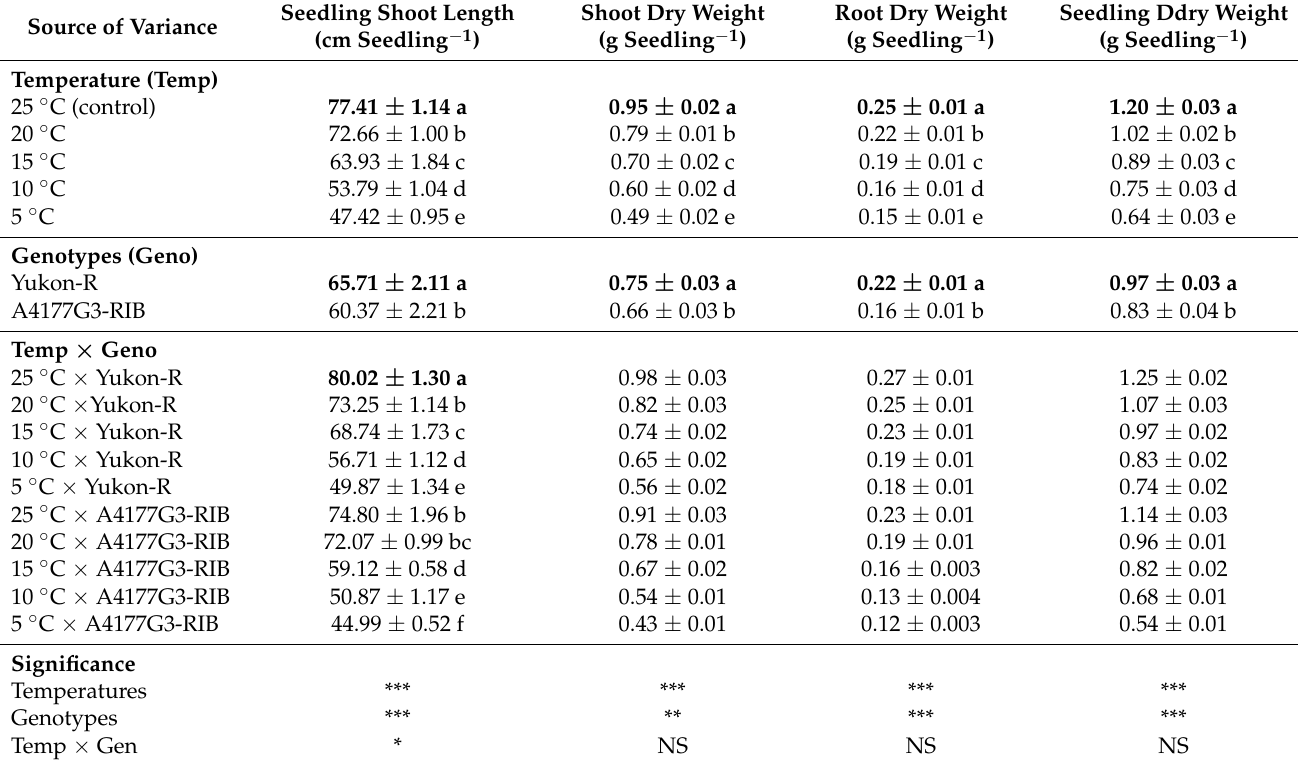
Table 1. Effects of temperature regime on seedling shoot length, shoot dry weight, root dry weight, and total seedling dry weight of two silage corn genotypes cultivated in hydroponics under controlled environmental